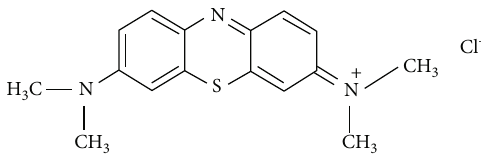
Figure 1: Chemical structure of methylene blue dye.